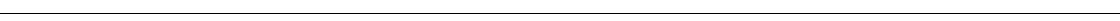
Fig. 8 The role of GEF-H1 in neuronal polarization in vivo a pT α -LPL-Lyn-EGFP was coelectroporated with T α -Cre and pT α -LPL (control), pT α -LPL-GEF-H1 – WT, – T103E, or – T103A into cerebral cortices at E13 followed by fi xation at E16. Coronal sections were prepared and immunostained with an anti-EGFP antibody ( green ). Nuclei were stained with Hoechst 33342 ( blue ). The tracing images depict EGFP-labeled cells ( bottom panels ). Scale bars, 100 μ m. b Quanti fi cation of the distributions of EGFP-positive cells in distinct regions of the cerebral cortex (CP and IZ). c Percentages of EGFP-positive cells with bipolar (BP) or multipolar (MP) morphologies in the cerebral cortex. d , e Percentages of trailing process-positive d or leading process-positive e neurons (pT α -LPL-EGFP = 6, pT α -LPL-GEF-H1-WT = 9, pT α -LPL-GEF-H1-T103E = 9, pT α -LPL-GEF-H1-T103A = 4 brains from three